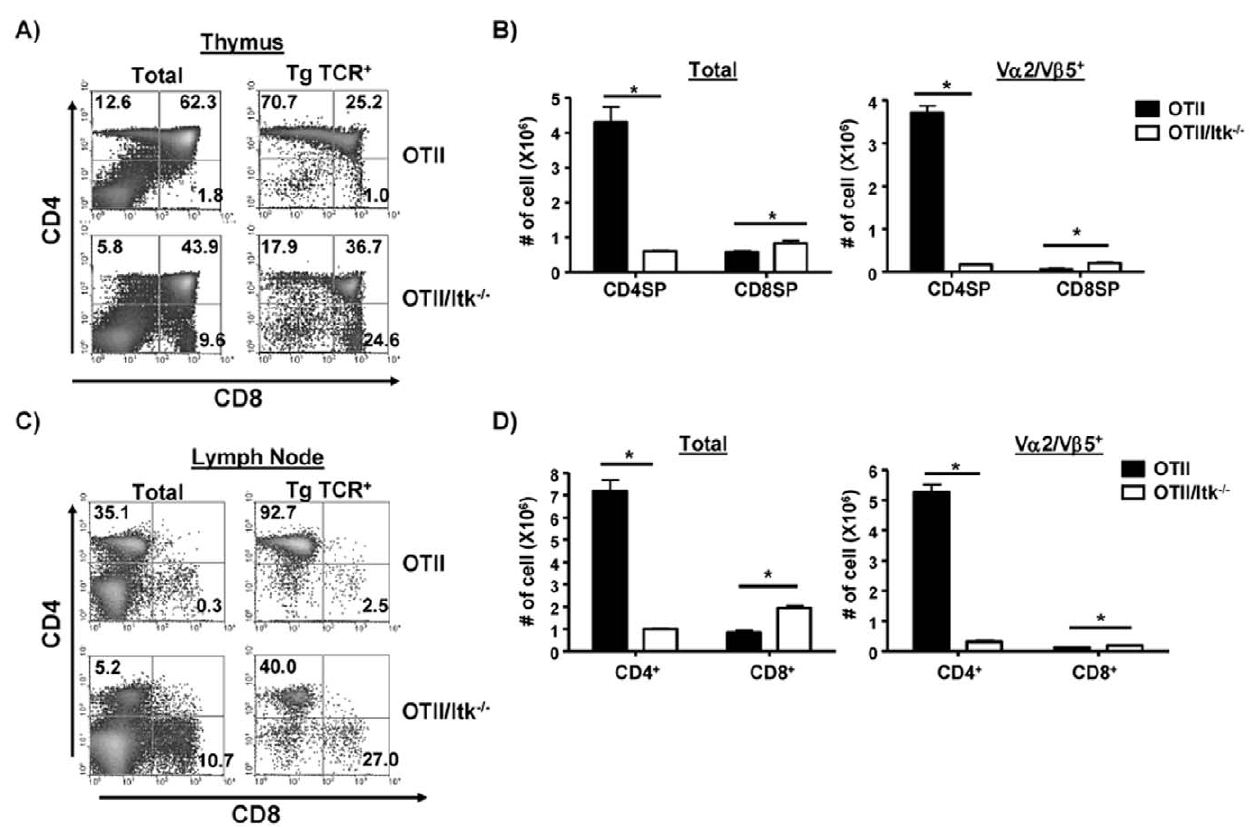
Figure 3. The absence of Itk affects the development of CD4 + T cells in OT-11 transgenic mice. ( A ) Total thymocytes (left panels) or the transgenic TCR + (V a 2/V b 5) population from OT-II and OT-II/Itk 2 / 2 mice analyzed for expression of CD4 and CD8 (right panel). ( B ) The number of thymocytes (total, left) or transgene TCR hi thymocytes (right) in WT and Itk 2 / 2 mice. *p , 0.05, n=3–5 mice. ( C ) Total lymphocytes (left panel) or the transgenic TCR + (V a 2/V b 5) population (right panel) from cervical lymph nodes of OT-II and OT-II/Itk 2 / 2 mice analyzed for expression of CD4 and CD8. ( D ) The number of total lymphocytes (left) or the transgene TCR + T cells from cervical lymph nodes (n=3–5, *p , 0.05).